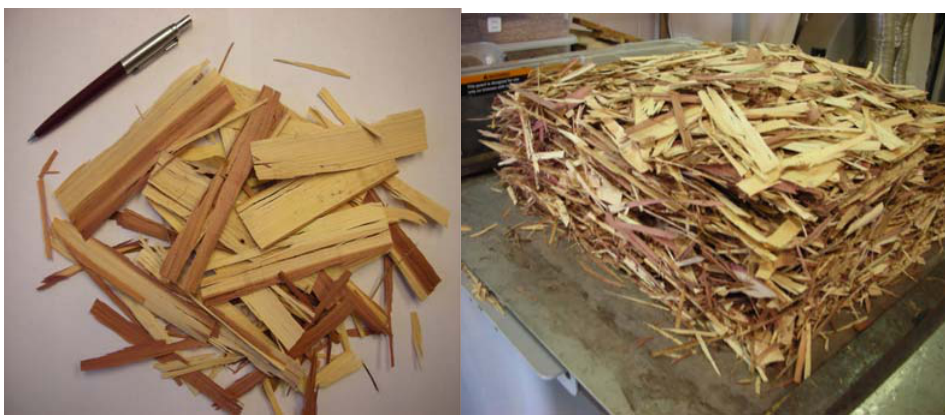
Figure 2. Eastern redcedar strands, unpressed mat, and finished